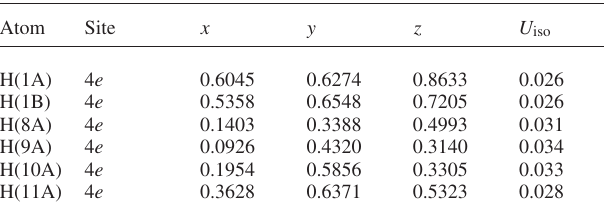
Table 2. Atomic coordinates and displacement parameters (in Å 2 )